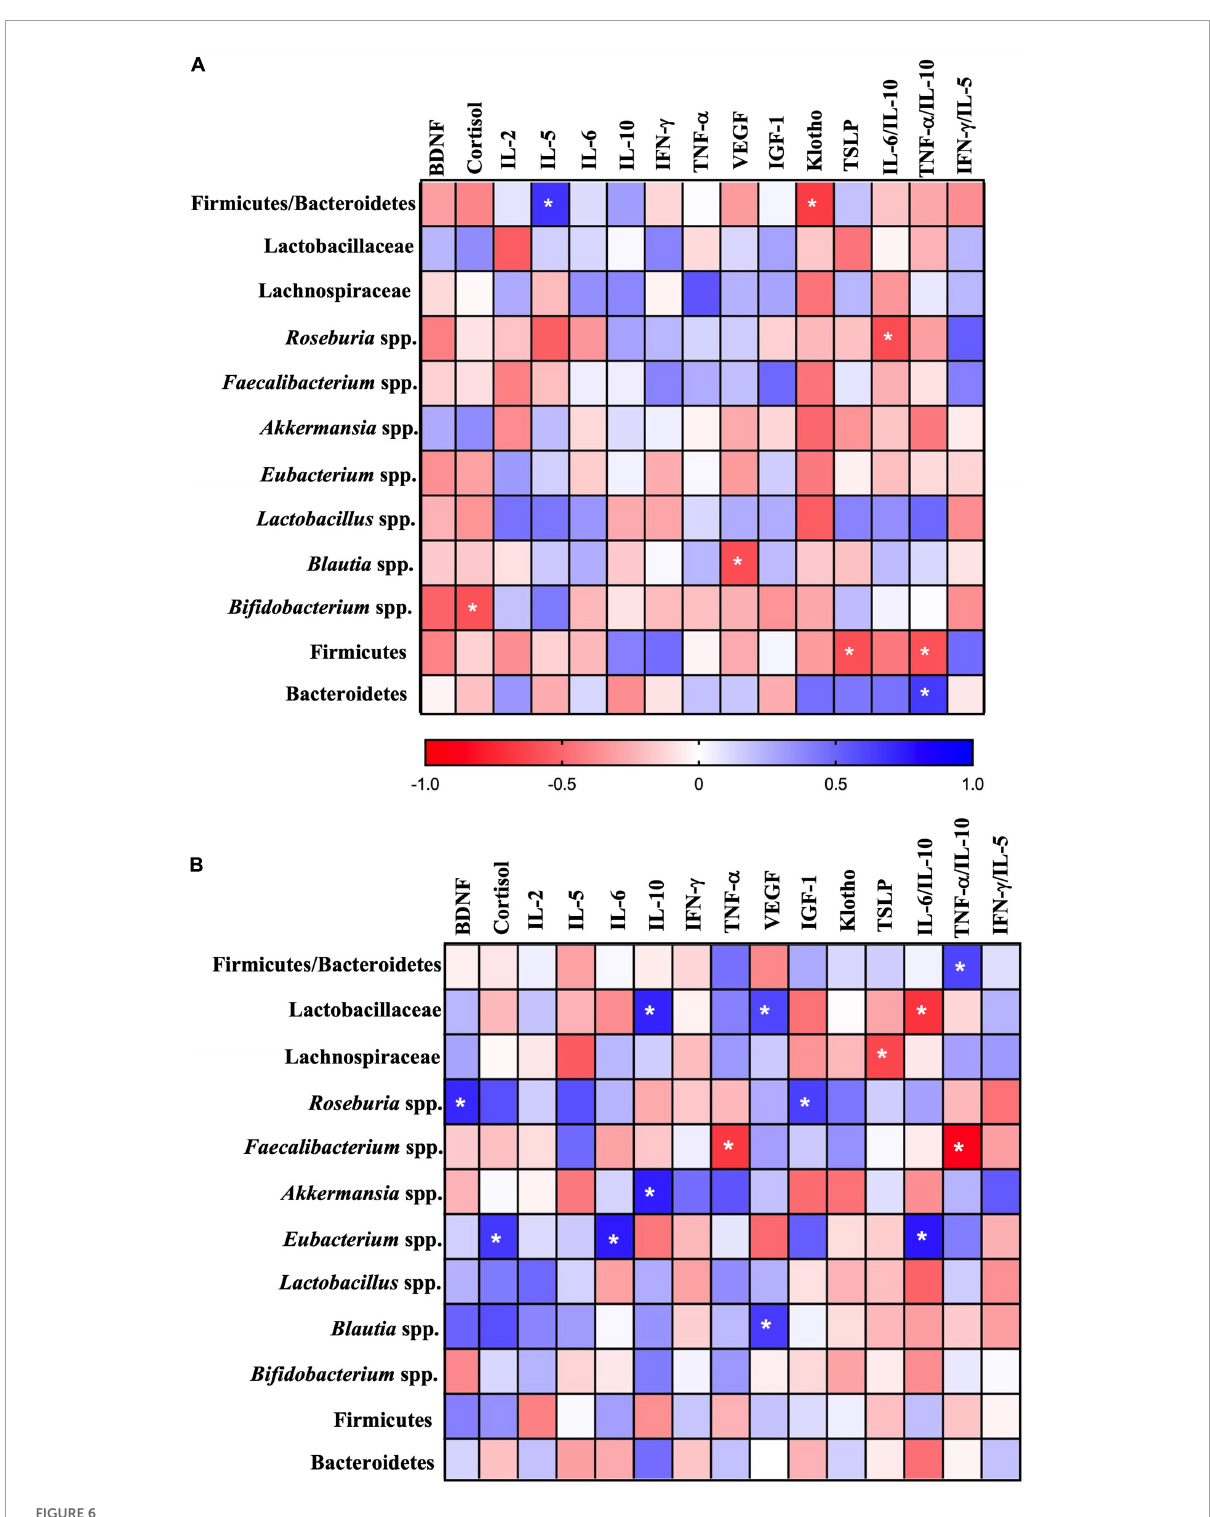
FIGURE6 Spearman correlation between serum markers and microbiota composition before (T0, A ) and after 6 months of physical distancing (T1, B ). The heat maps illustrate the R -value, in accordance with the intensity of colors (horizontal bar). Red represents negative correlations while blue represents positive correlations. * illustrates the significant correlations ( p < 0.05). BDNF, brain-derived neurotrophic factor; IL, Interleukin; IFN- γ , interferon-gamma; TNF- α , tumor necrosis factor-alpha; VEGF, vascular endothelial growth factor; IGF-1, insulin-like growth factor-1; TSLP, thymic stromal